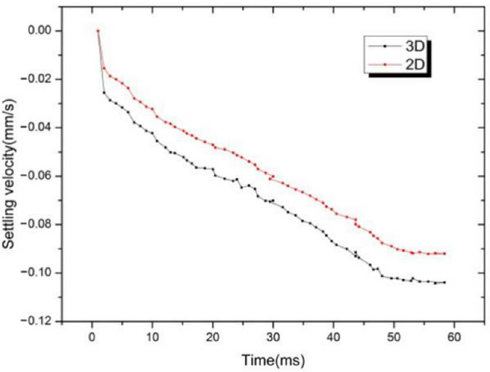
Figure 6. Falling velocity rates for 2D and 3D dendrites.